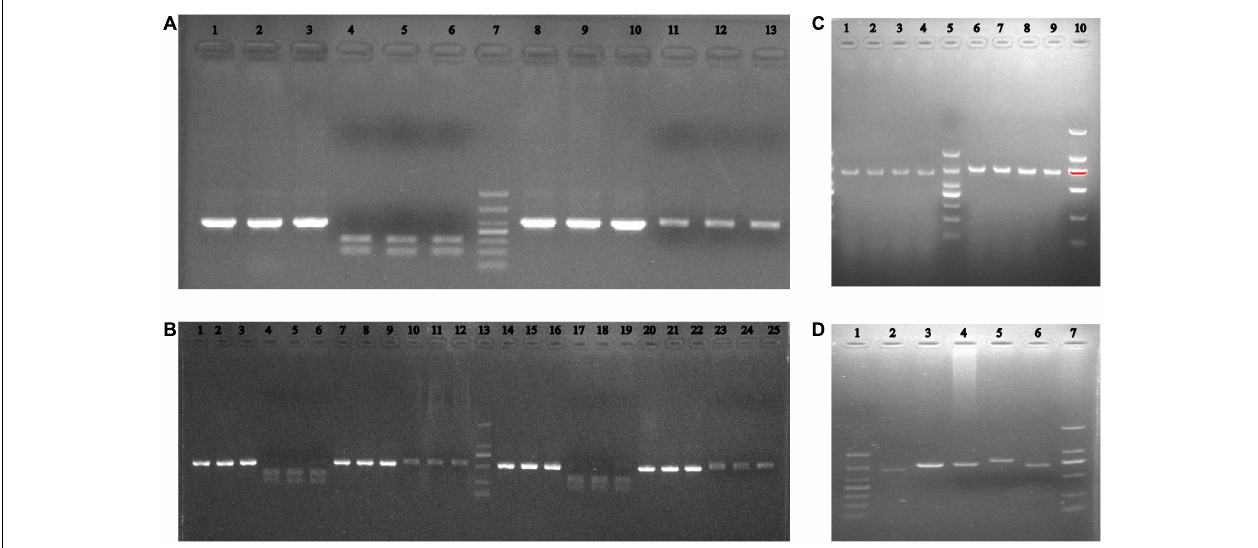
FIGURE 5 | Agarose electrophoresis of PCR-RFLP for ITS1 for oysters. (A) Lane 1–3 are PCR product of ITS1 of three individuals and lane 4–6 are corresponding digested product by Hind III restricted enzyme of Crassostrea angulata from ZZ and lane 8–13 are PCR product and corresponding digested product for Crassostrea sikamea from YQB and lane 7: DL1000 DNA marker. (B) Lane 1–6, 7–12: PCR product and corresponding digested product of three Crassostrea angulata and three Crassostrea sikamea individuals in XSB and lane 14–25 for SMB, lane 13:DL2000 DNA marker. Verification of MNR specific identification primer, agarose electrophoresis of (C) oysters samples from different geographic locations, lane 1–4: SMB, YQB, and ZZ, 6–9: C.angulata in XSB, SMB, YQB and ZZ; 5&10: DL1000 and DL2000 DNA marker; (D) five Crassostrea oysters, lane 2: Crassostrea sikamea , 3: C.angulata , 4: C.gigas ,5 C.ariakensis ,6: C.hongkongensis and lane 1&7: DL1000 and DL2000 DNA